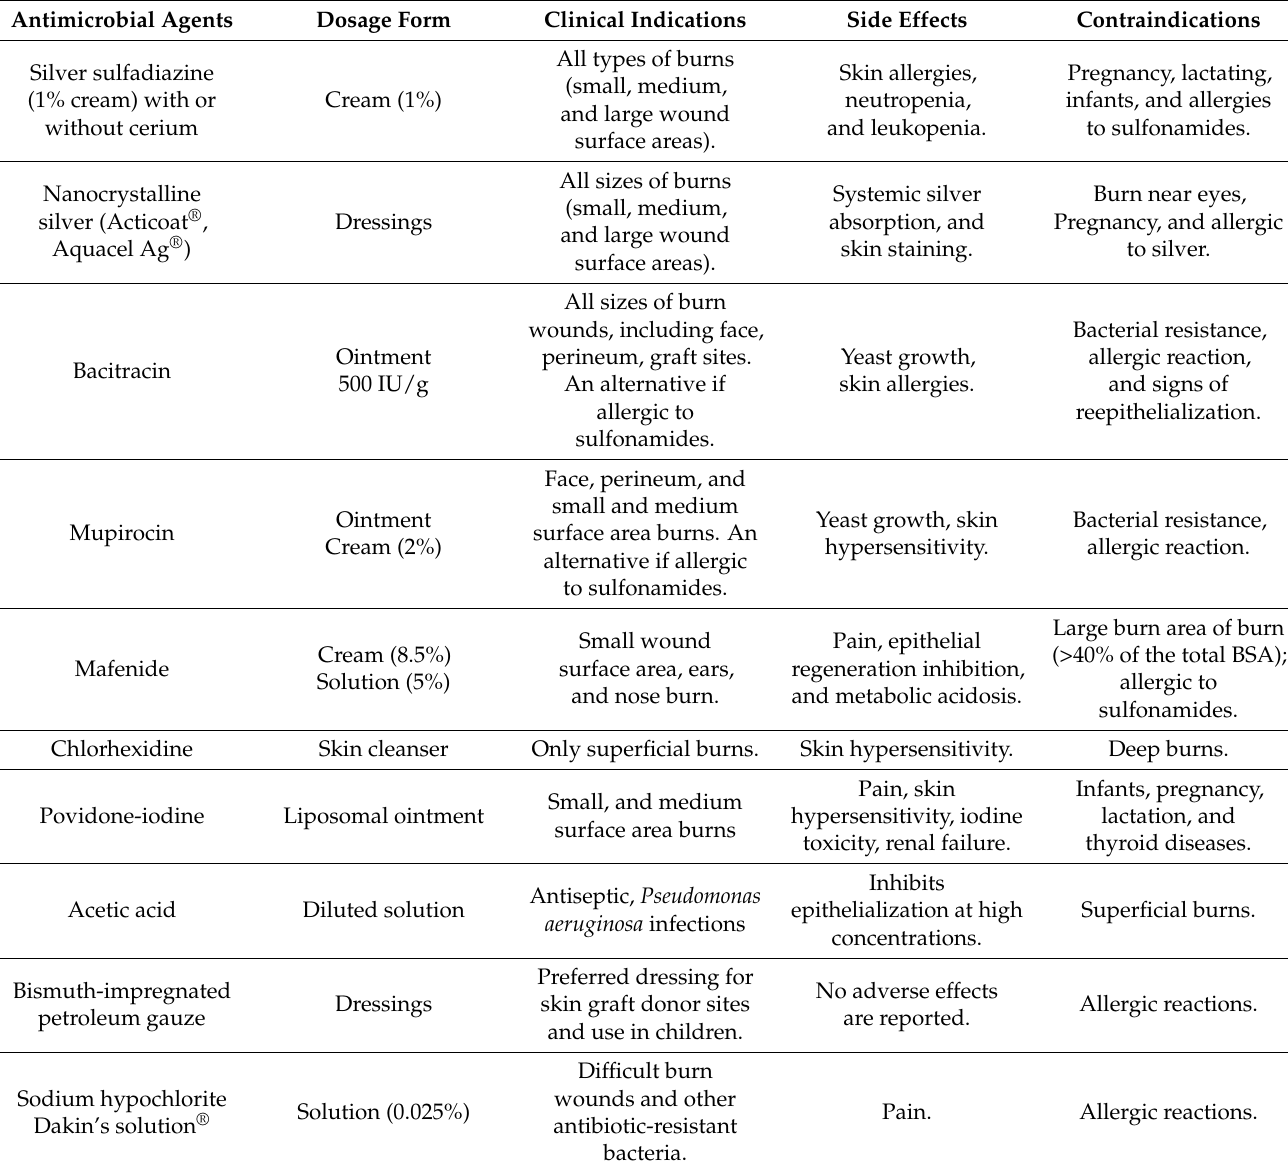
Table 3. Current topical antimicrobial treatment for burn wounds. Antimicrobial Agents Clinical Indications Side